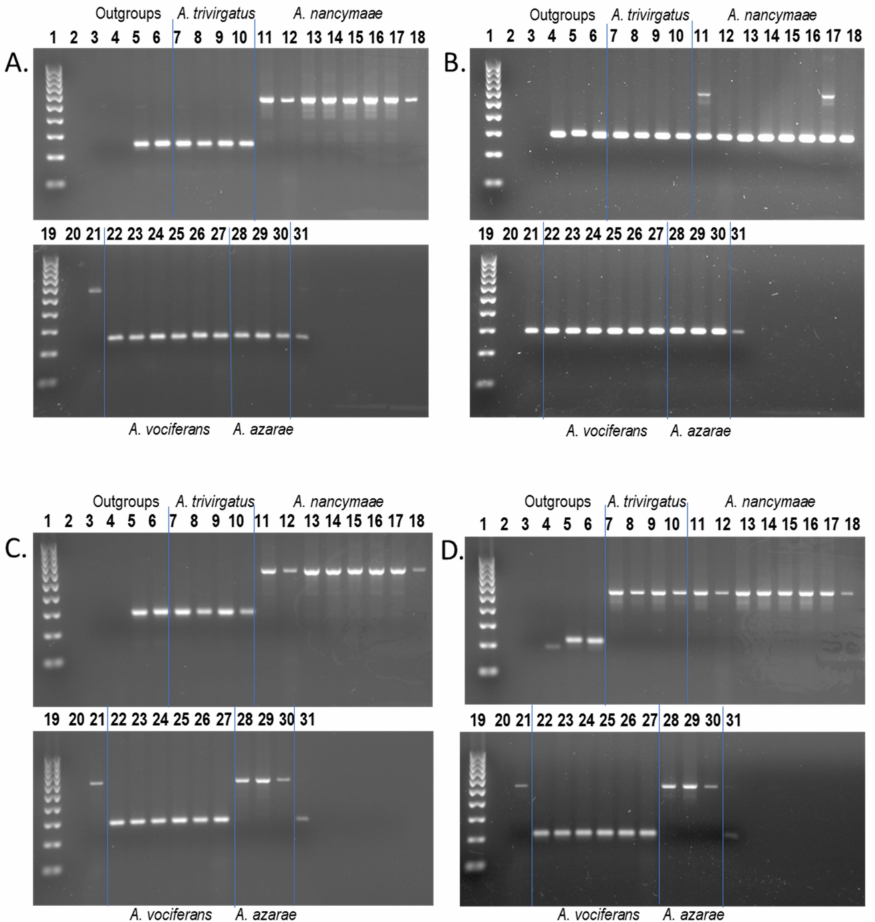
Figure 1. Aotus Alu insertion polymorphisms. Lanes: 1, 19—100 bp DNA ladder; 2,